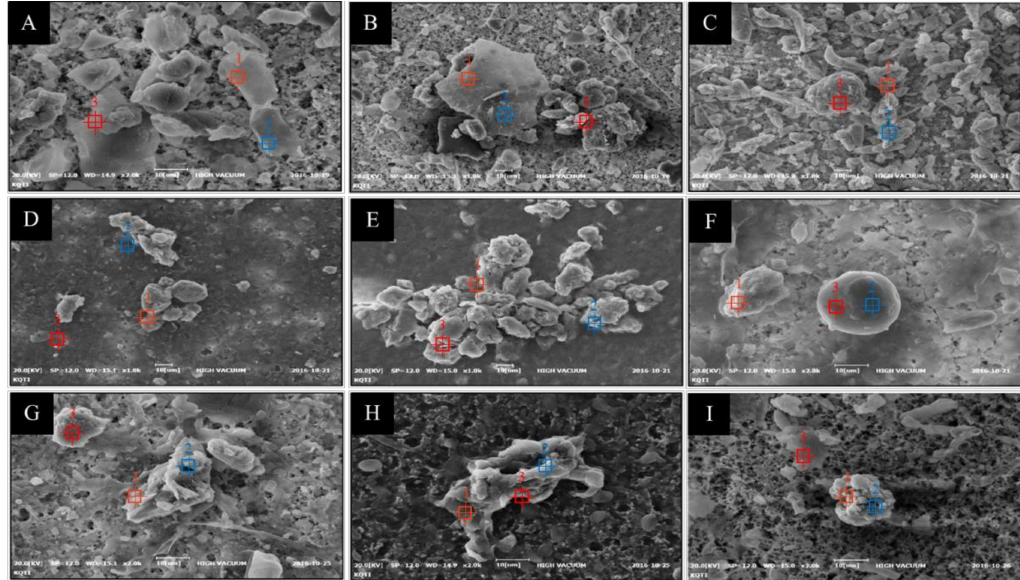
Figure 6. Size and morphology of particulate matter (PM) adsorbed on leaf surfaces, used to determine the elemental composition of PM shown in Table 3. Analytical images were taken randomly from all leaf samples of tree species used in the study. PM with high O, C, and Ca content ( A , B , G , I ), and PM containing a lot of H and N with irregular shapes ( C – F , H